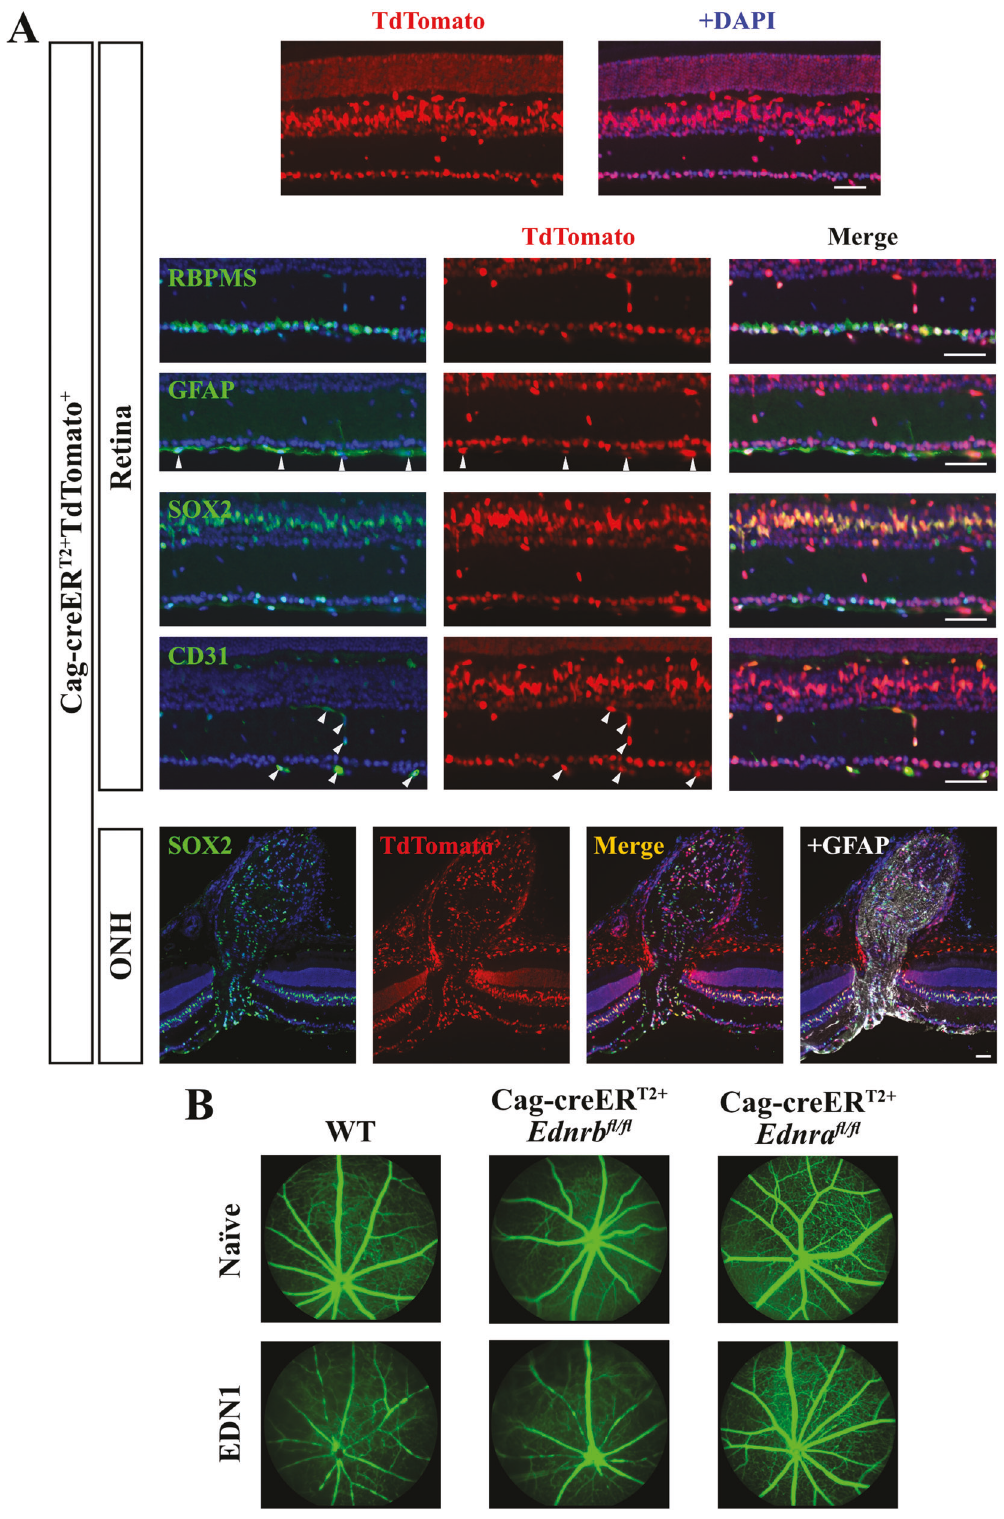
Fig. 2 Cag-creER T2 robustly recombined fl oxed alleles in retinal and optic nerve DAPI + cells. A Cag-creER T2 + Tdtomato + retinal and optic nerve head sections depicting cell-type-speci fi c expression of Tdtomato. Cag-creER T2 robustly recombined fl oxed alleles in DAPI + cells, including RBPMS + RGCs, SOX2 + Müller glia, GFAP + retinal astrocytes, CD31 + vascular cells, and SOX2 + GFAP + optic nerve head (ONH) astrocytes ( n = 3). Scale bars, 50 μ m. B Fluorescein angiography of retinal vasculature in naive and EDN1-injected eyes from WT, Cag-creER T2 + Ednrb fl / fl , and Cag- creER T2 + Ednra fl / fl animals. Full body deletion of Ednra ablated EDN1-induced vasoconstriction ( n ≥ 5).